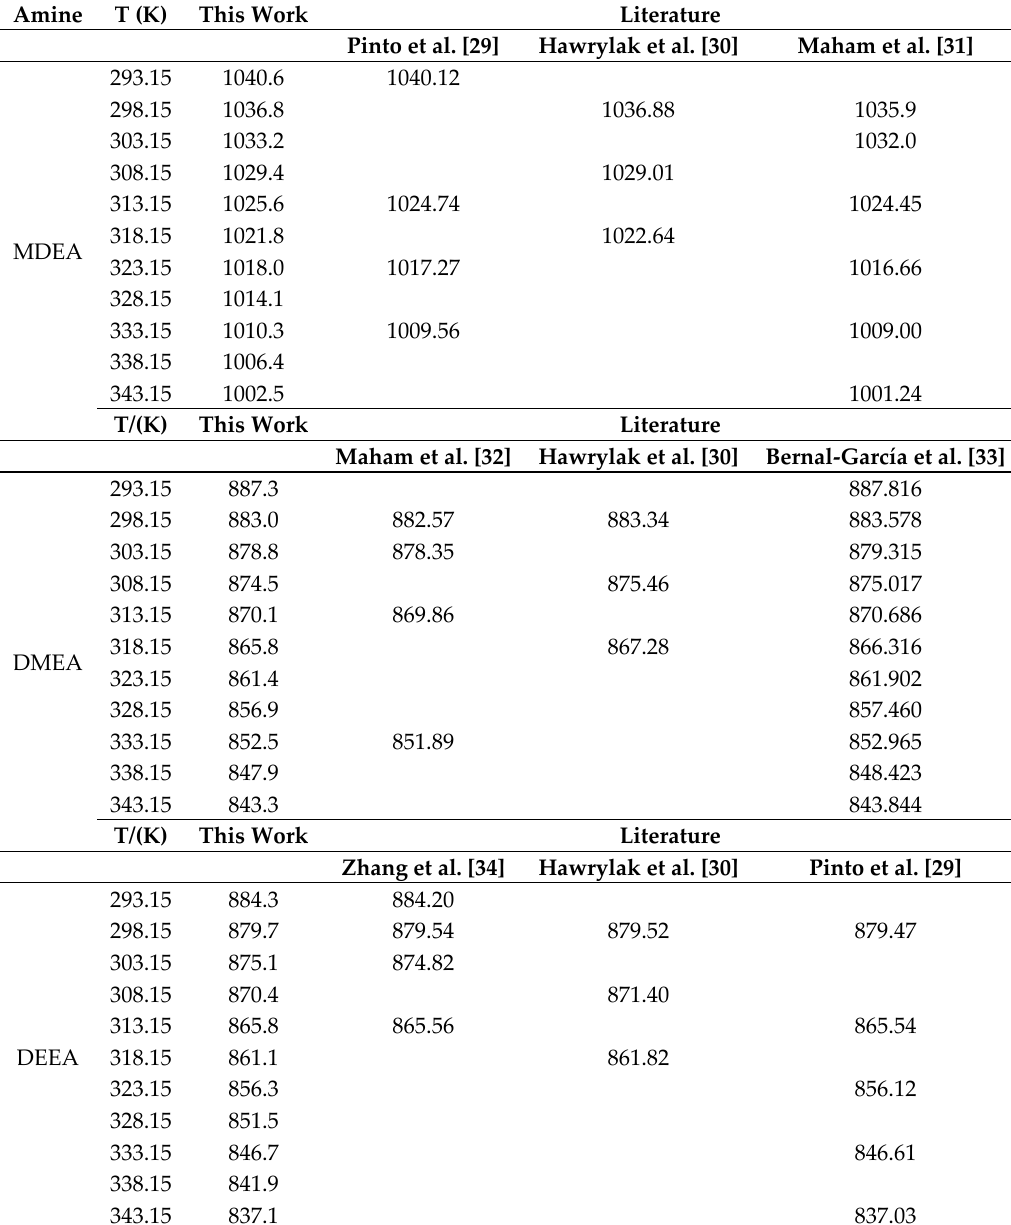
Table 2. Densities 𝜌 /kg · m −3 of pure amines MDEA, DMEA and DEEA.